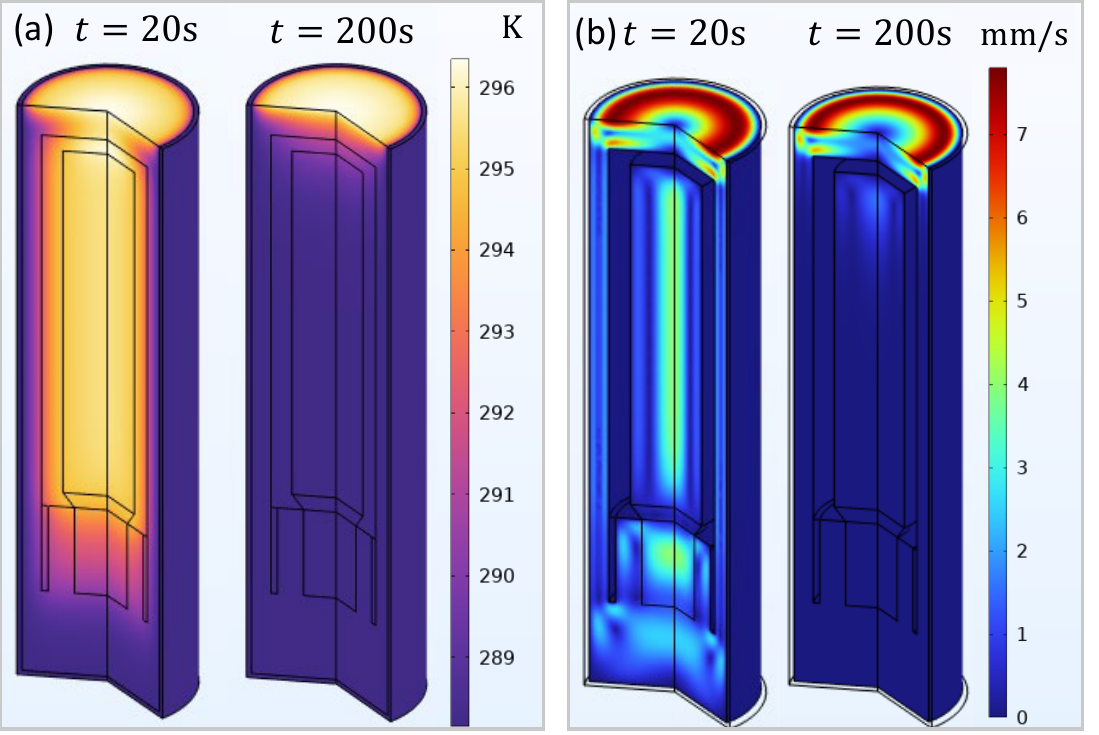
Figure 5. ( a ) Temperature field distribution in the glass tube at t = 20 s and t = 200 s. ( b ) Velocity field distribution in the glass tube at t = 20 s and t = 200